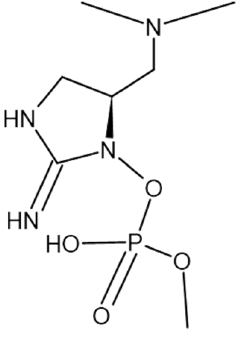
Figure 4. Anatoxin-a(s).